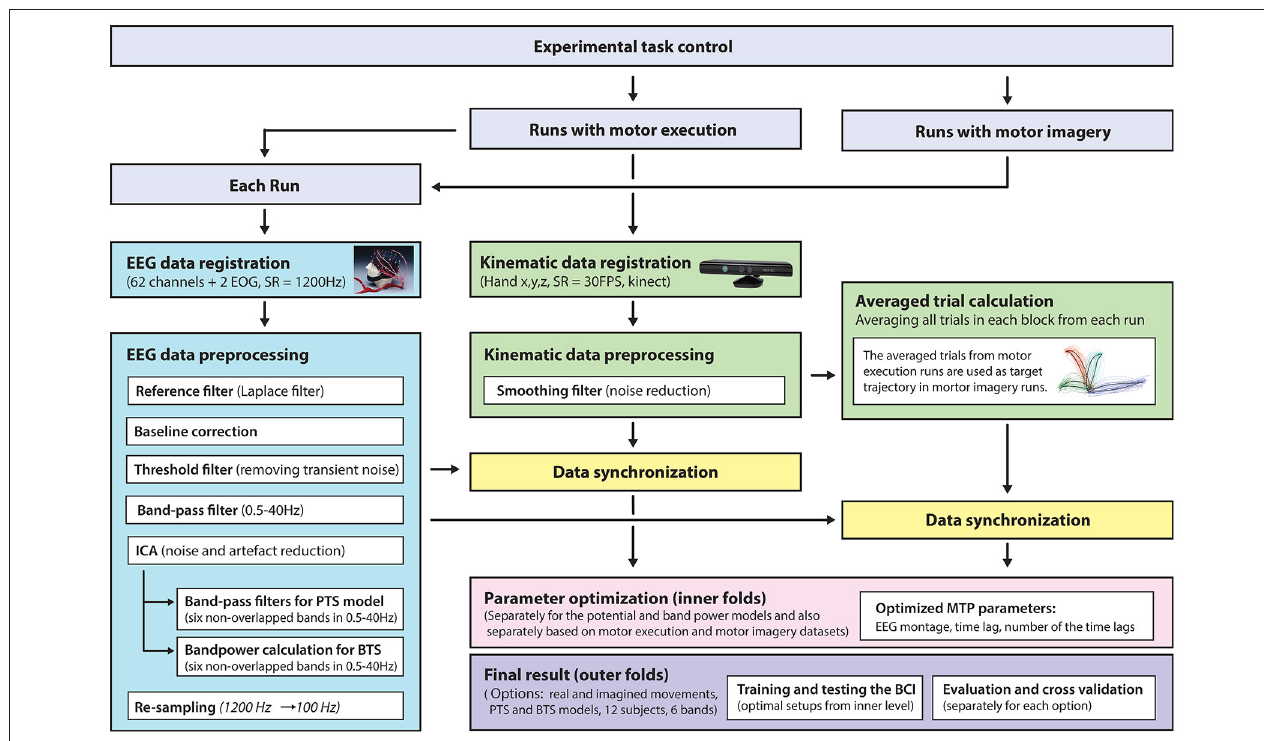
FIGURE 5 | Signal processing pipeline—from data acquisition to evaluation. EEG and kinematic data were parallel registered during the task and preprocessed offline. For motor imagery runs, the target kinematic trajectories were calculated by averaging the kinematic data in the executed movement run prior to the corresponding imagined movement run. The optimal time lag, embedding dimension, and most prominent frequency bands were selected using a three-step procedure for finding optimal parameters. The parameter optimization and final results were calculated in framework of the inner-outer cross-validation technique.